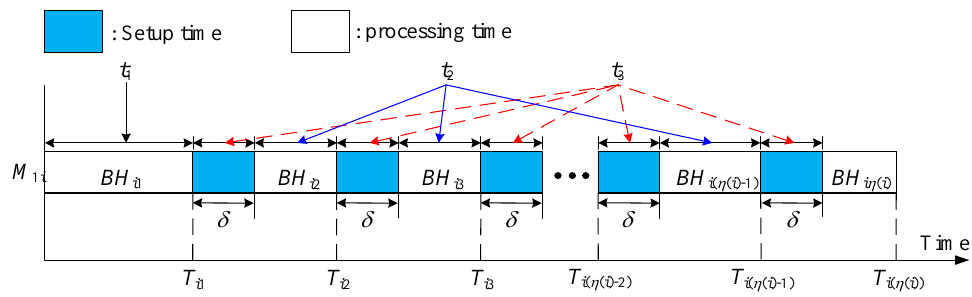
Figure 3. Illustration for Theorem 1.